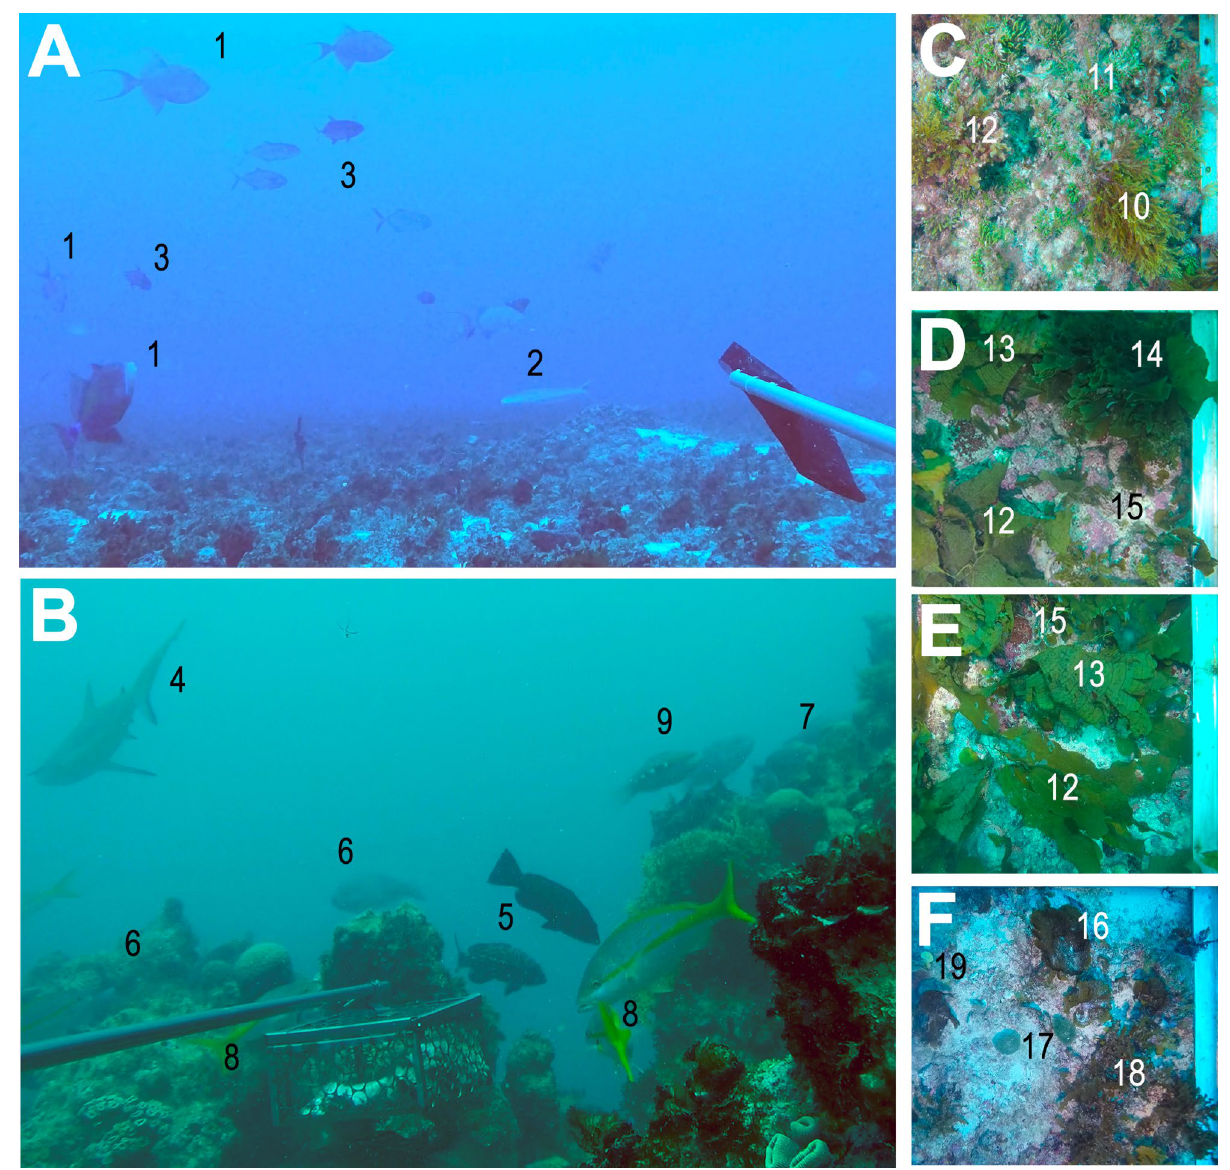
Figure 5. Video frames showing fish and benthic assemblages in reefs ( a ) and rhodolith beds ( b – f ). The right row shows orthogonal images from rhodolith bed sites marked with stars in Fig. 1, from the most inshore ( c ) to the most offshore ( f ). Legends: 1 = Balistes vetula , 2 = Malacanthus plumieri , 3 = Caranx crysos , 4 = Charcharhinus perezi , 5 = Mycteroperca bonaci , 6 = Scarus trispinosus , 7 = Malacanthus plumieri , 8 = Ocyurus chrysurus , 9 = Scarus zelindae , 10 = Dictyota sp., 11 = Caulerpa sp., 12 = Dictyopteris sp., 13 = Stypopodium sp., 14 = Zonaria sp., 15 = Crustose Coralline Algae, 16 = Lobophora sp., 17 = Penicillus sp., 18 = Sargassum sp. Images obtained by R. L. Moura and G. M.